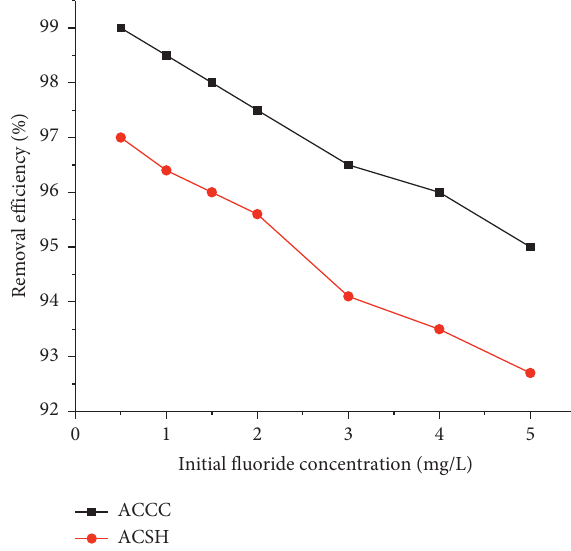
Figure 8: Effect of concentration on fluoride removal efficiency of activated carbon of corncob and sorghum husk (dose � 6g contact time � 1h) with an initial fluoride concentration of 5.0mg/L at pH 7.